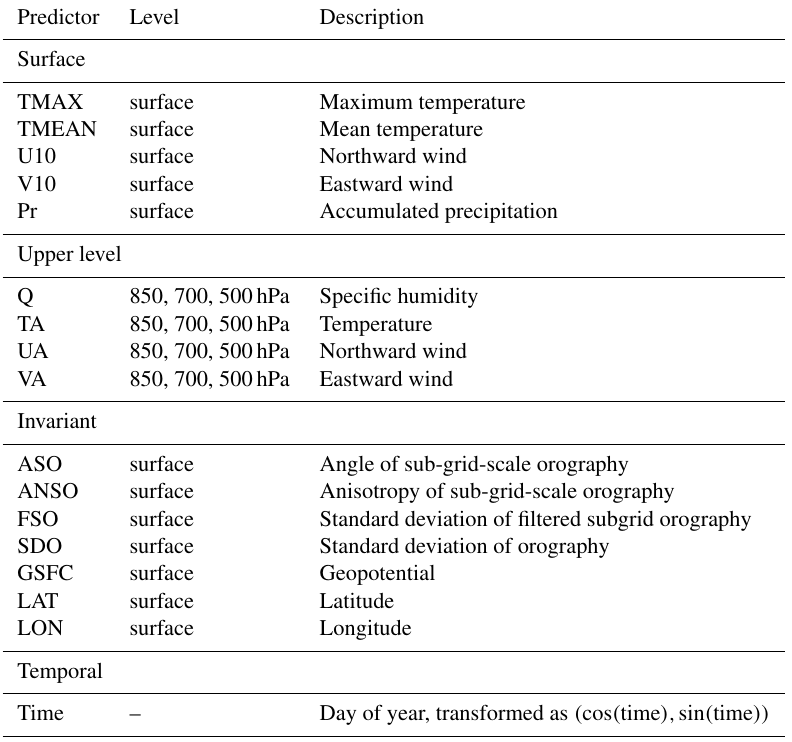
Table 1. Gridded predictors from ERA-Interim reanalysis included in Z .